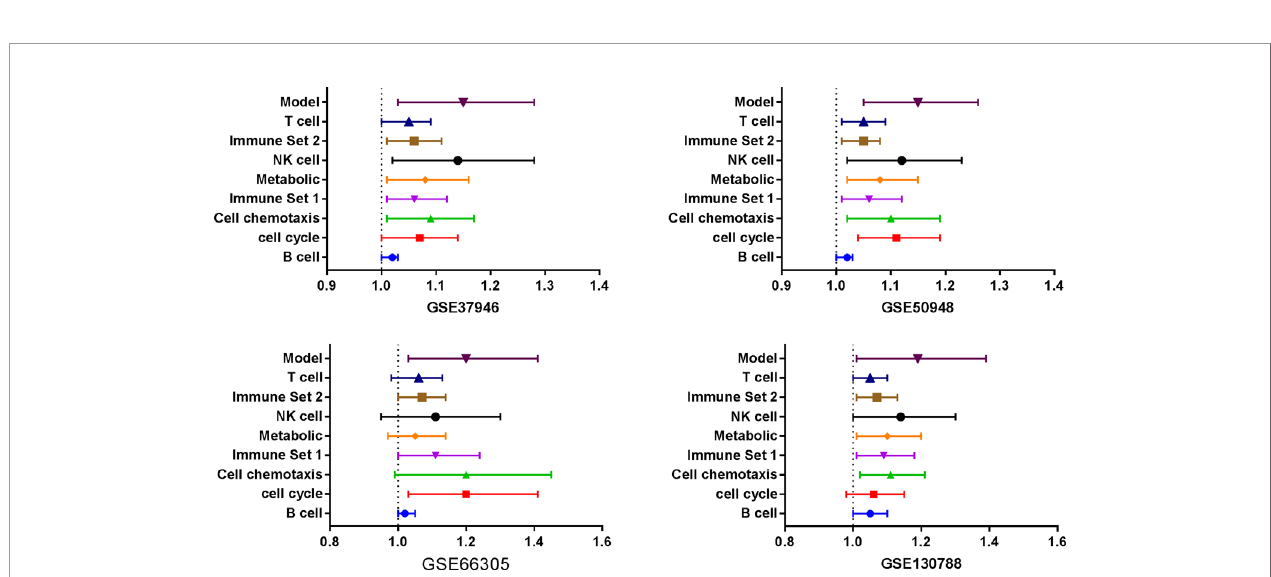
FIGURE 4 | Immune signatures and model between pathological complete response and non- pathological complete response in different